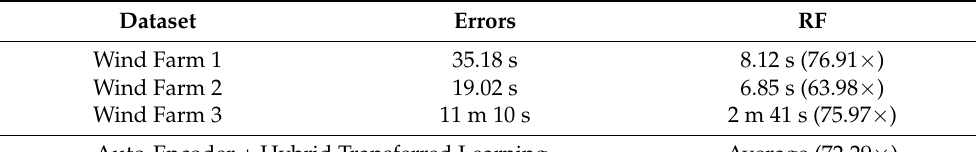
Table 6. Runtime Comparison before and after using Auto-Encoder + Hybrid Transferred